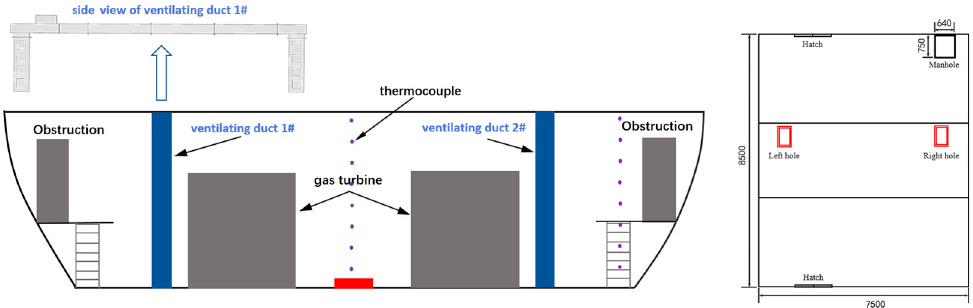
Figure 1. Front view ( left ) and top view ( right ) of the experimental cabin.